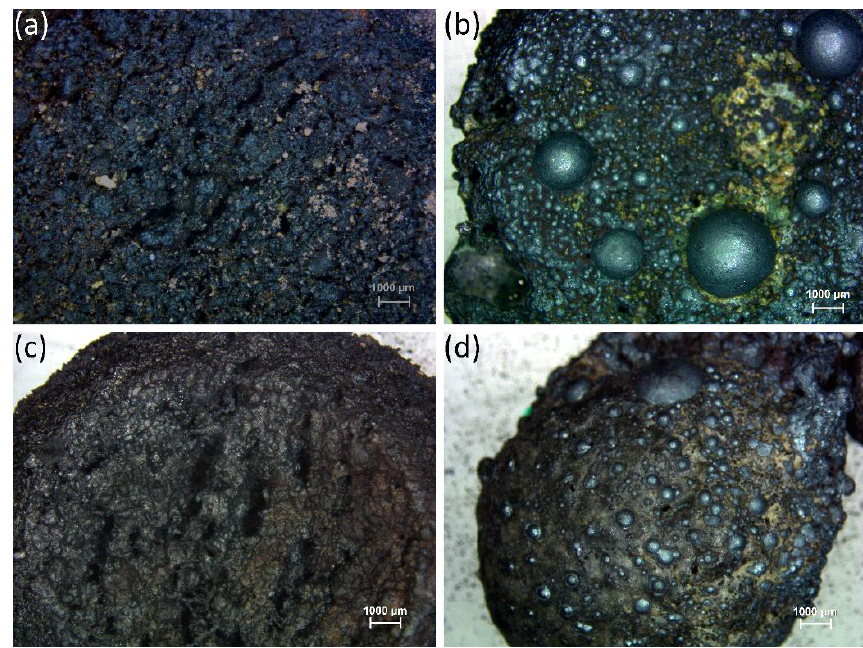
Figure 6. Stereo microscope images of the sample reduced through graphite (C2) at ( a ) 1200 °C; ( b ) 1500 °C and blast furnace sludges (A2) ( c ) 1200 °C; ( d ) 1500 °C.